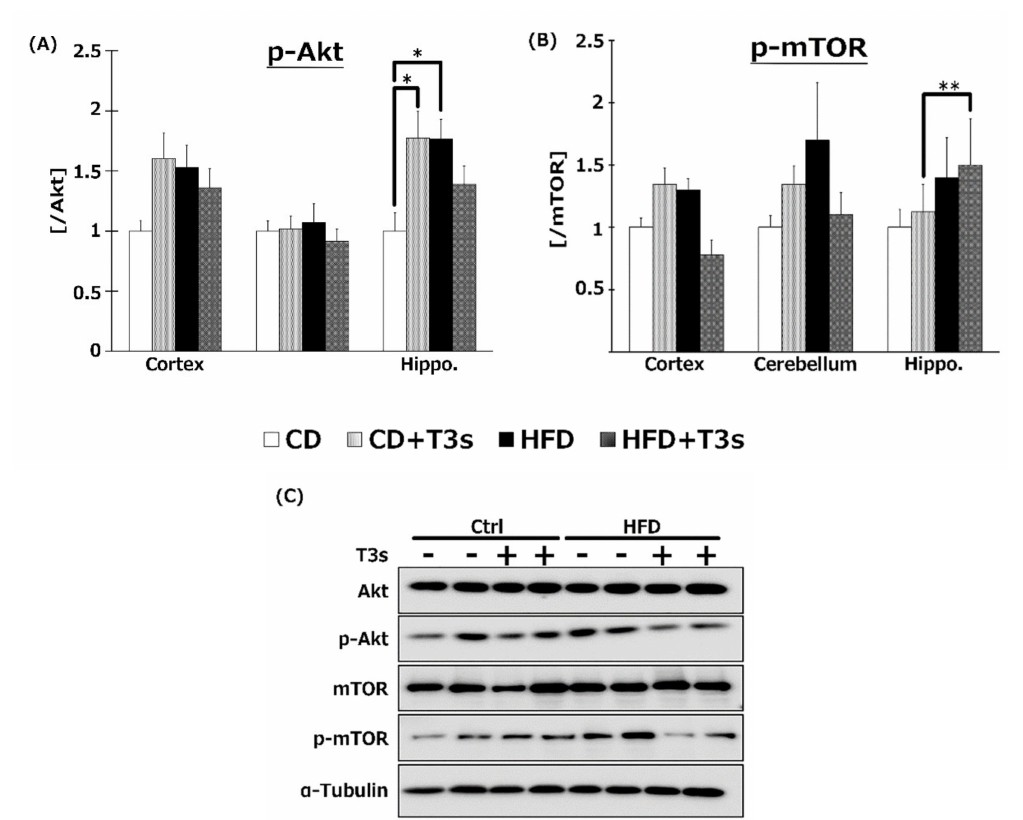
Figure 9. Western blotting analysis of p-Akt ( A ) and p-mTOR ( B ) protein expression. Images of Western blots for each protein examined in cortex ( C ). CD = Control diet ( n = 10), CD + T3s = CD + T3 mix ( n = 10), HFD = high-fat diet ( n = 10), HFD + T3s = high-fat diet + T3-mix ( n = 10). Data are expressed as mean ± SE. Tukey–Kramer’s method: * p < 0.05, ** p <